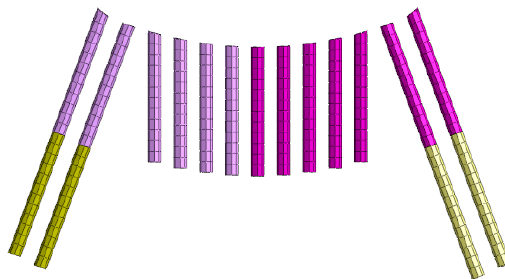
Figure 17. Optimized pile length.